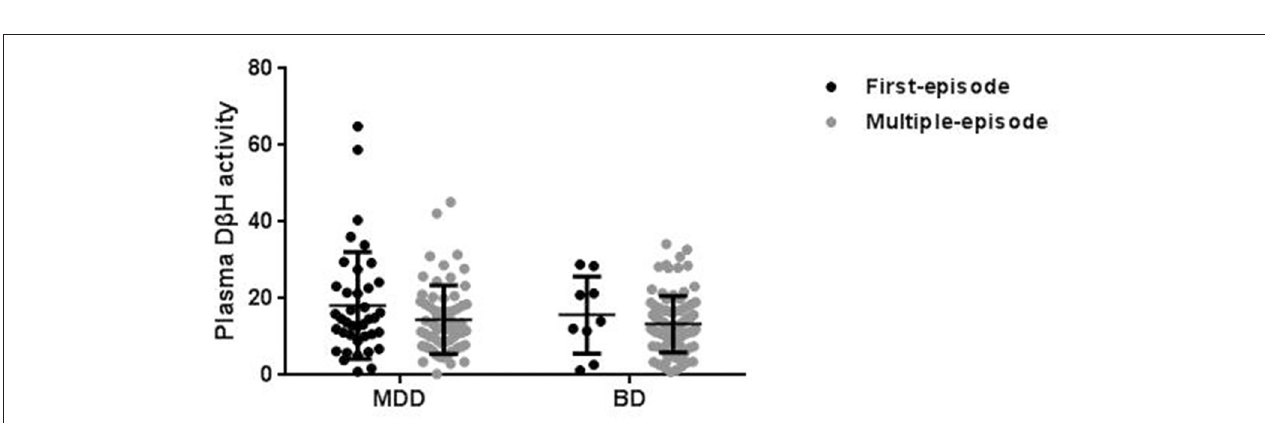
FIGURE 1 | Plasma D β H activity in patients with MDD or BD, and healthy controls (HC). (A) Compared the plasma D β H activity in HC ( n = 160), MDD patients ( n = 104), and BD patients ( n = 101). (B) Showed the sex difference of D β H activity among HC ( n = 80 in males; n = 80 in females), MDD patients ( n = 54 in males; n = 50 in females), and BD patients ( n = 62 in males; n = 39 in females). (C,D) Showed the age-dependent changes of D β H activity in each group. Data was presented as mean ± S.D. ** p < 0.01.